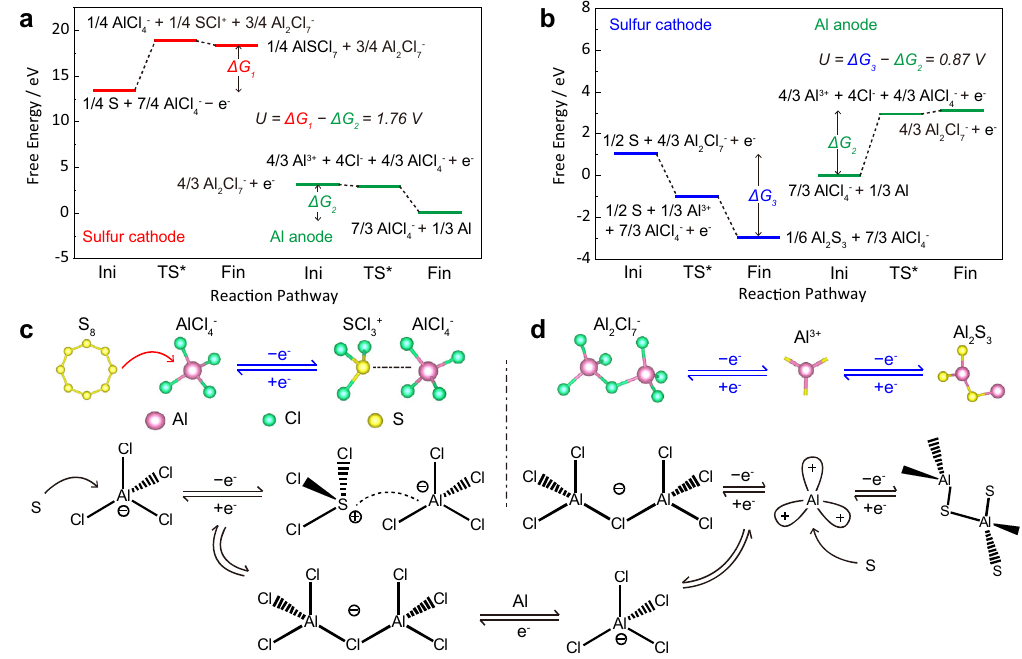
Fig. 3 Theoretical computations of reaction pathways for sulfur oxidation and sulfur reduction. The reaction pathway of sulfur cathode and Al anode for a sulfur oxidation and b sulfur reduction; schematics for c sulfur oxidation and d sulfur reduction processes with AlCl 4 − and Al 2 Cl 7 − anions,